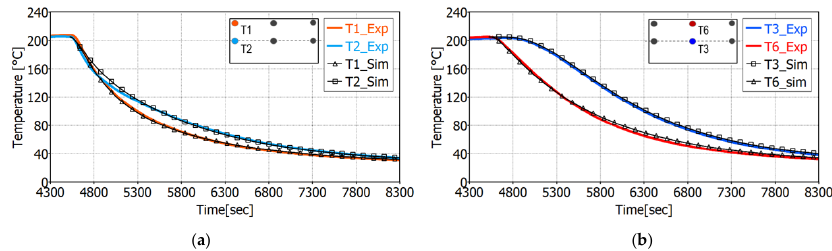
Figure 7. Temperature along the radial direction ( a ) in the face of the monolith (at 5 mm from inlet face) and ( b ) in the center of the monolith (at 63.5 mm from inlet face). Test1-Tinit = 200 °C, Inclination = 0°.